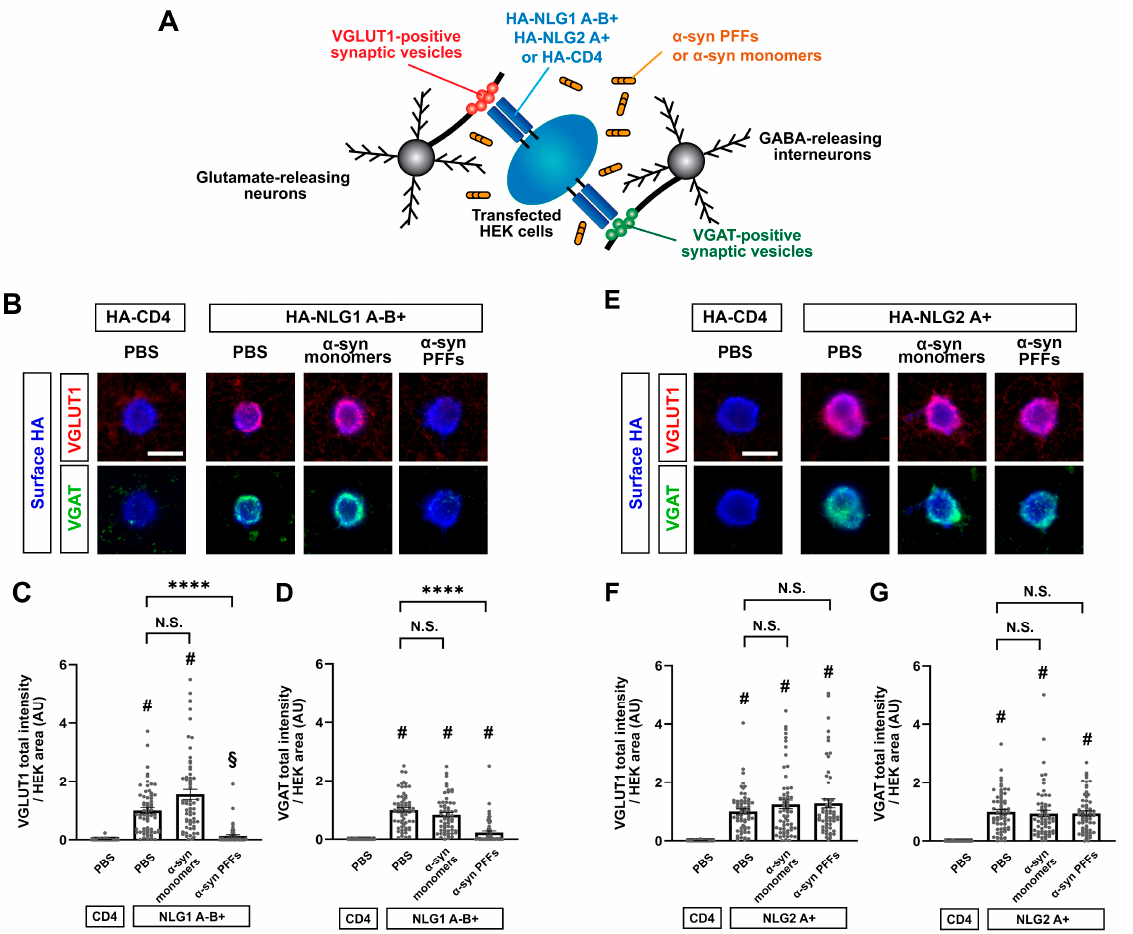
Figure 7. Co-culture-based artificial synapse formation assays reveal that α -syn PFFs